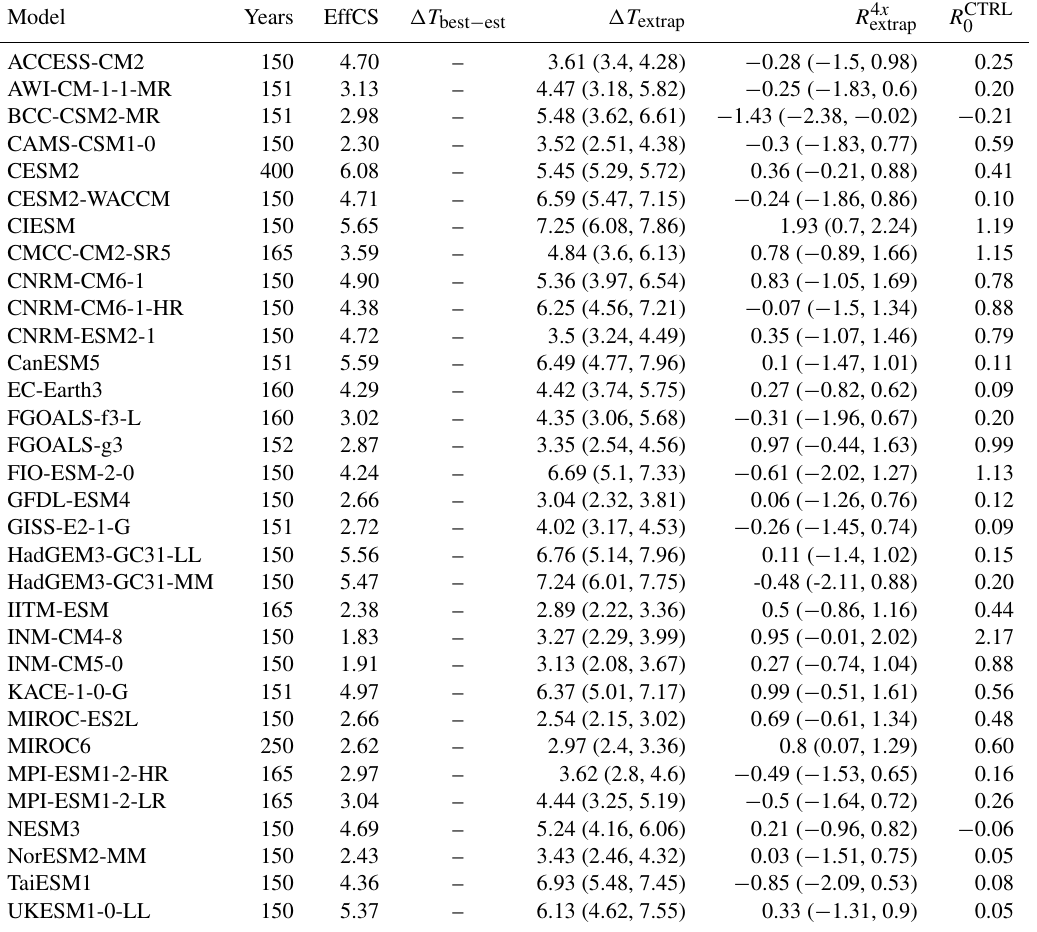
Table A3. Fitted parameters and uncertainties for the CMIP6 experiments.